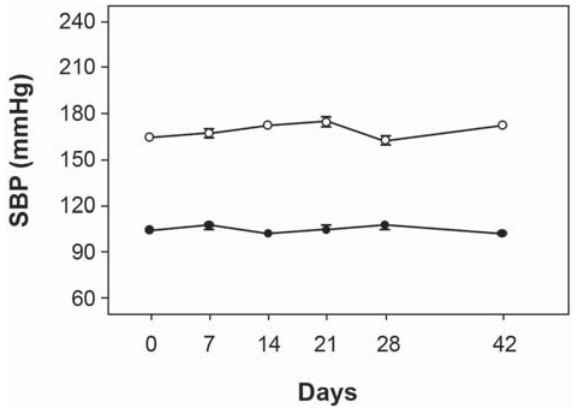
Figure 1- Systolic arterial blood pressure (SBP) of Wistar rats (closed circles, n=5) and spontaneously hypertensive rats (SHRs) (open circles, n=5). Symbols represent means±SEM of the experiments